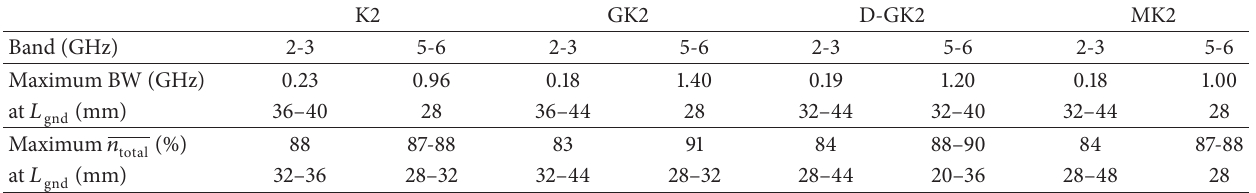
Table 3: Comparison of well-performing GNDP lengths between the four dual-band printed IFAs in terms of bandwidth and efficiency.